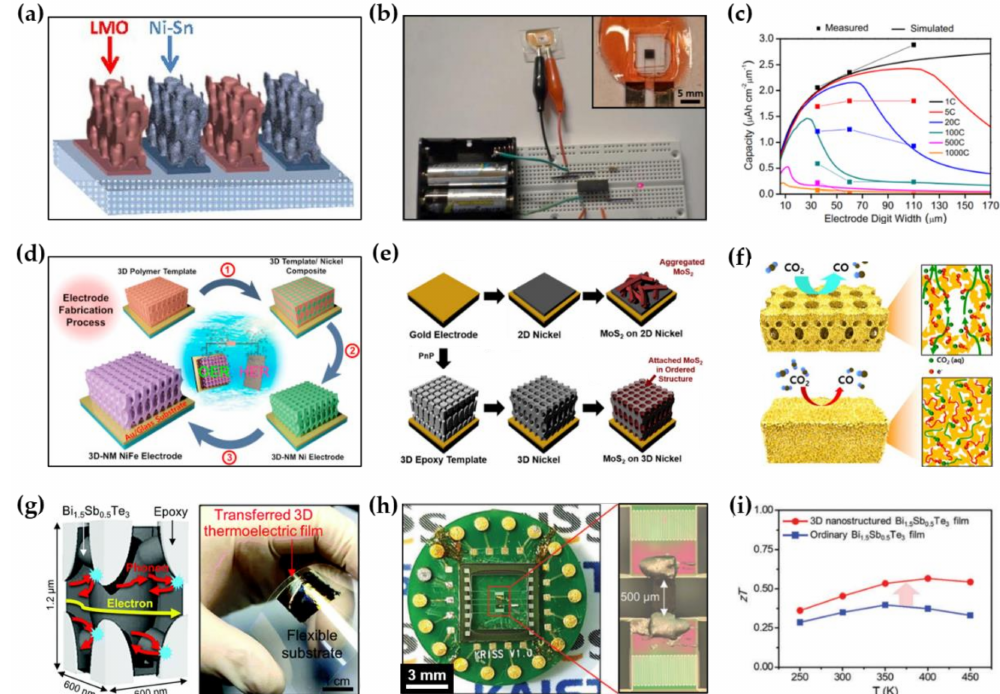
Figure 7. Non-optical applications of 3D nanostructured functional materials: ( a ) Schematic illustration of the interdigitated electrodes with lithiated MnO 2 (LMO) cathode and Ni-Sn anode; ( b ) Digital image of microbattery setup; ( c ) Capacity as a function of electrode digit (reprinted with permission from [53]. Copyright 2015 The National Academy of Science); ( d ) Schematic illustration of fabrication processes of a 3D-nanomesh (NM) Ni electrode (reprinted with permission from [82]. Copyright 2018 Elsevier); ( e ) Schematic illustration of the fabrication processes of a 3D Ni with 2D MoS 2 (reprinted with permission